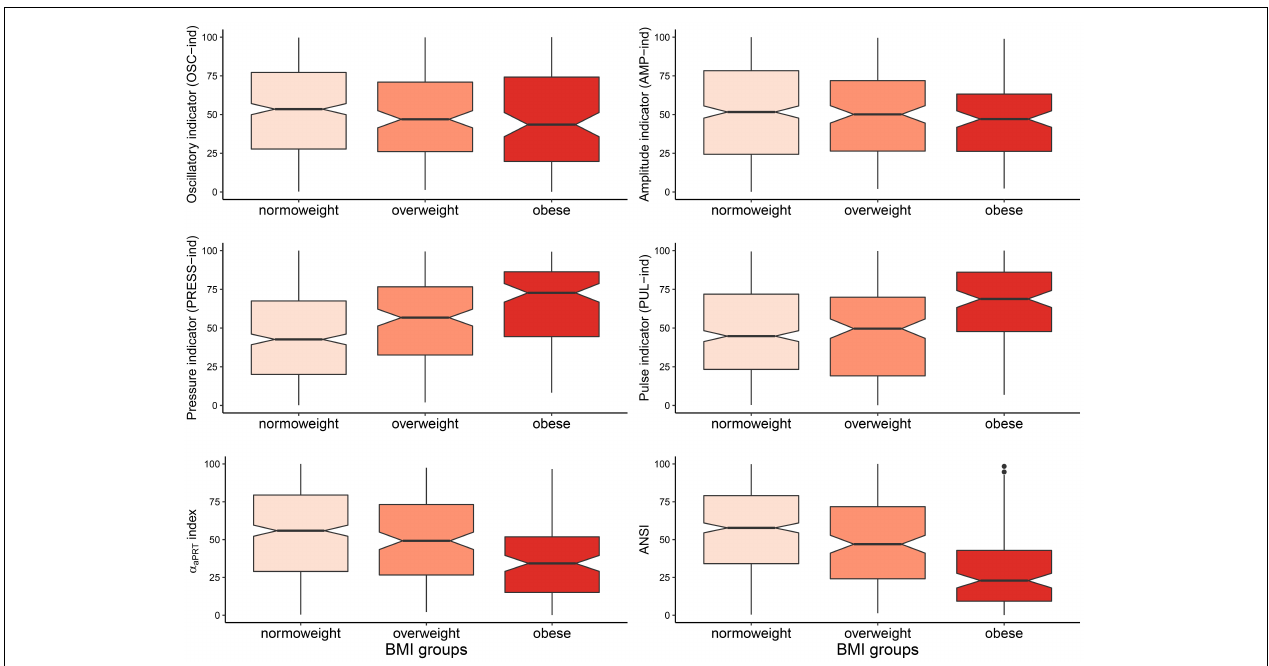
FIGURE 4 | Notched box plots of the distributions of the four ANS indicators, the α aPRT index, and ANSI within the BMI groups. Notches around the sample medians med g ( Y ) of the synthetic indicator Y within the BMI groups: g = normoweight (NW), overweight (OW), obese (OB), are given by the formula: √ med g ( Y ) ± 1 . 58 IQR g ( Y )/ n g , where IQR g ( Y ) = Q 3 , g ( Y ) − Q 1 , g ( Y ) is the interquartile difference for Y within group g with sample size n g , and Q 1 , g and Q 3 , g are the first and third quartiles, respectively (McGill et al., 1978; Chambers et al., 1983; Wickham, 2016). Notches providing an approximate 95%-confidence interval for the corresponding population medians can be used as a convenient graphical tool for comparing pairs of groups. If the notches of the medians of two groups do not overlap, then there may be systematic differences in the population. Notches depicted in the above box plots are not, however, adjusted for